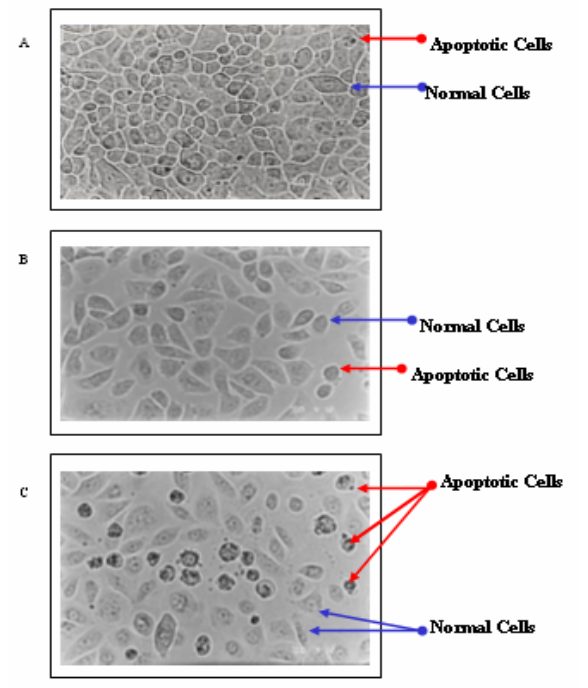
Figure 1: Morphology of Corneal Epithelial Cells by Phase Contrast Microscopy. Morphologic changes in corneal epithelial cells exposed to UVB by phase contrast microscopy (40X magnification).